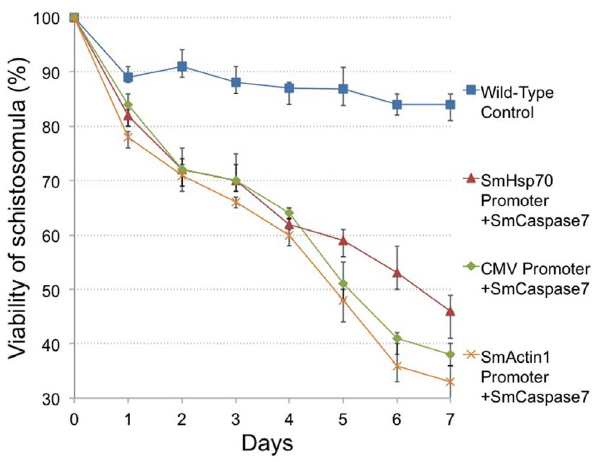
Figure 9. Schistosome viability after SmCaspase7 gene over- expression. Plasmid based Caspase 7 expression was regulated by SmActin1, CMV or SmHsp70 promoters in schistosomula for 7 days. Viability was assessed. Untransfected schistosomula served as an experimental control. Data are shown as a mean percentage of surviving larvae after assessment of three biological replicates.